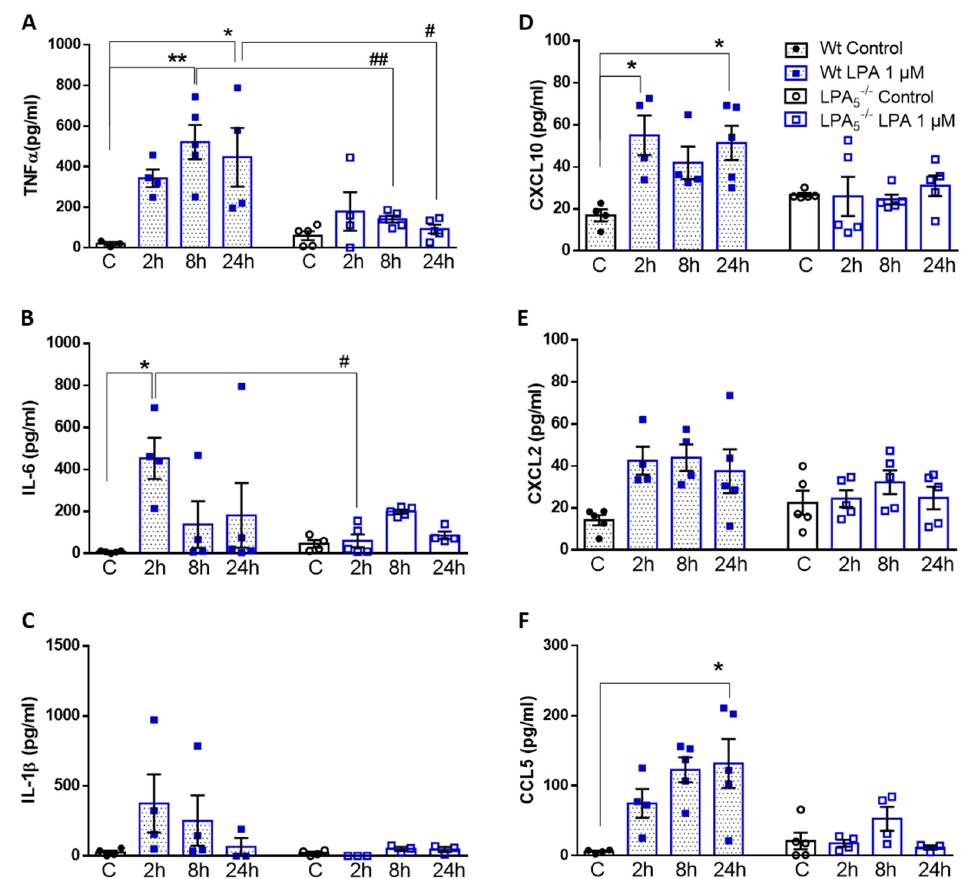
Figure 4. LPA 5 regulates LPA-induced secretion of cyto-/chemokines in primary microglia. Wt and LPA5 -/- cells were treated in the absence ( C ) or presence of LPA (1 µ M) for the indicated times. Supernatants were collected and ( A – C ) cytokine (TNF α , IL-6, and IL-1 β ) and ( D – F ) chemokine (CXCL10, CXCL2, and CCL5) concentrations were quantified by ELISA. Values are expressed as mean ± SEM of five independent experiments. * p < 0.05, ** p < 0.01 compared to wt control; # p < 0.05, ## p < 0.01 for LPA 5-/- compared to wt cells (two-way ANOVA with Bonferroni correction). To account for potential effects mediated by other LPA receptors (in particular LPA 6 that is highly expressed by primary microglia [18]) or potential LPA loss during sample LPA concentration was chosen to account for the lower LPA affinity of LPA 6 [17].